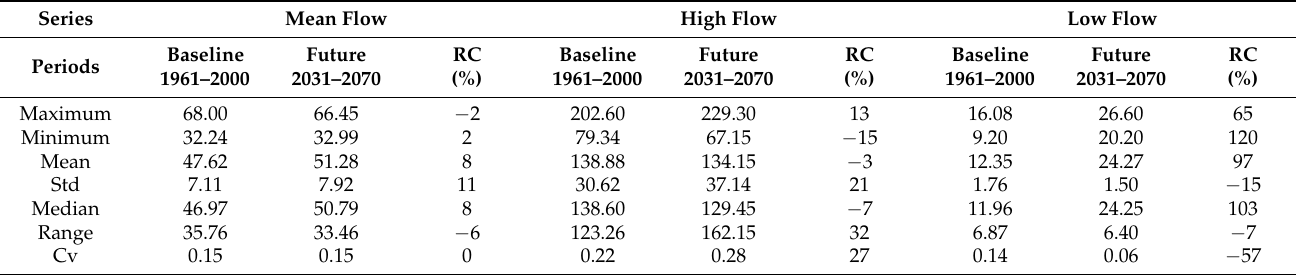
Table 5. Fitting results from GEV distribution